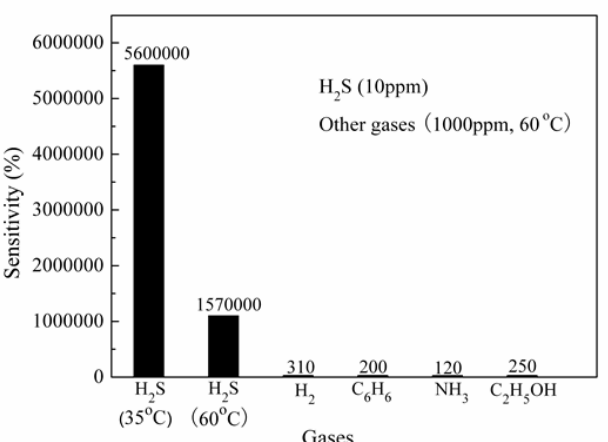
S gas from gas mixtures. Reprinted with permission Figure 13. Selectivity for H 2 from [116]. Copyright (2009) Springer.